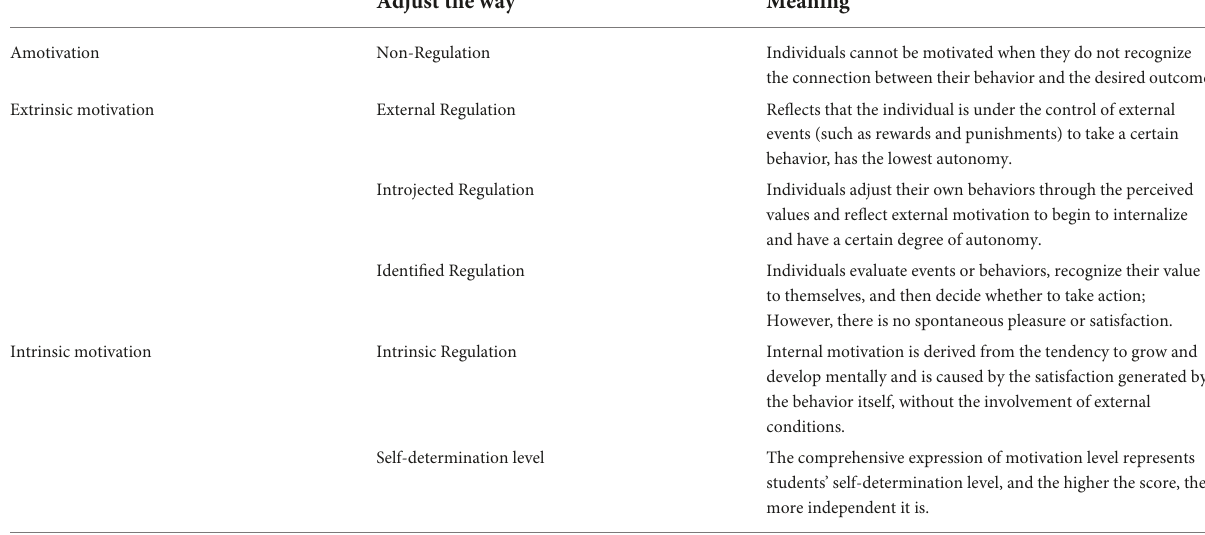
TABLE 1 Explanation of different forms of motivation regulation.